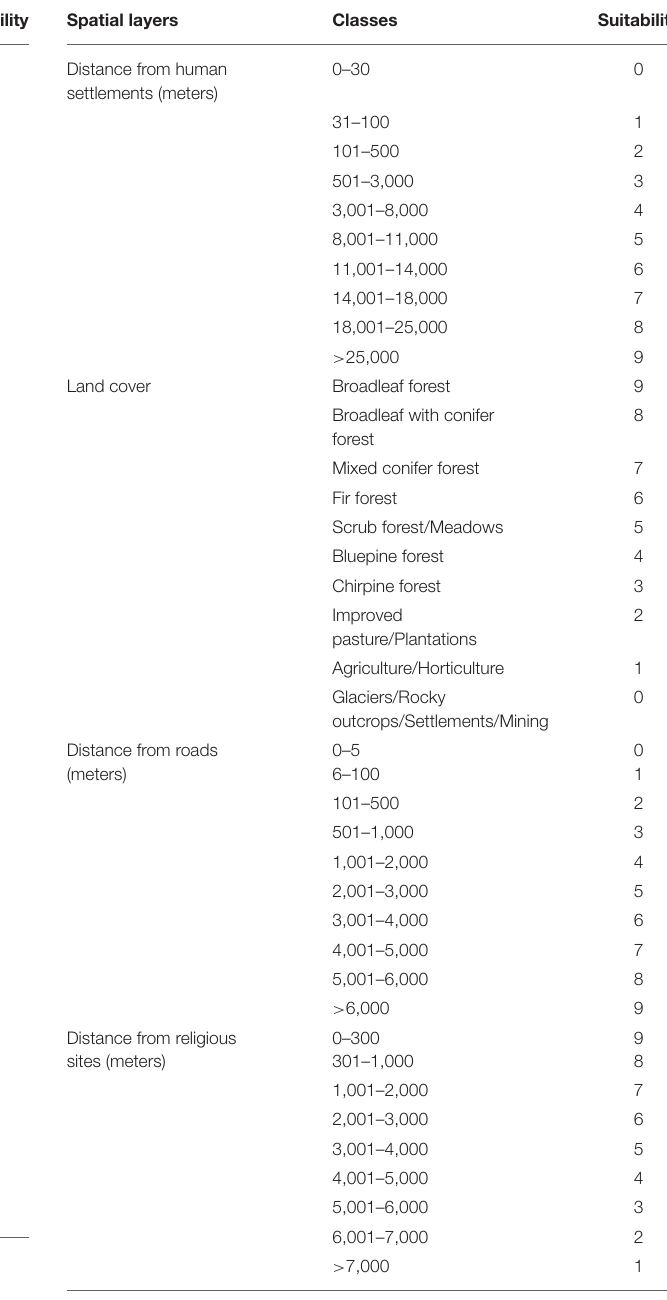
TABLE 2 | Land-use and anthropogenic variables with suitability values for dholes ( Cuon alpinus ). Spatial layers